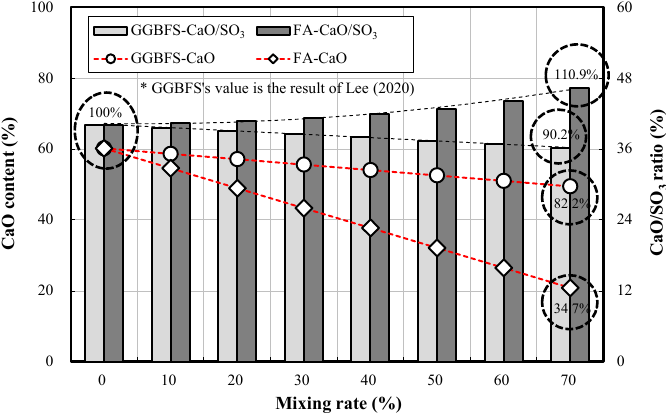
Figure 15. Results of the CaO content and CaO/SO 3 rate in terms of the mixing rate.